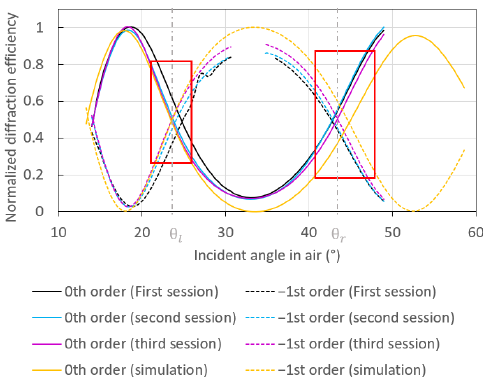
Figure 4. Normalized measured switch patterns (black, blue, and purple) obtained at different areas on the grating. θ l and θ r correspond to the left and right working points, respectively, where the diffraction efficiencies associated with the 0th and − 1st orders are equal. Both red boxes delimit the linear region of each working point. The normalized theoretical switch pattern (yellow) was computed using MC Grating. The period used in the computations was extracted from an AFM scan of the plasmonic grating tested, as highlighted by the yellow box in Figure